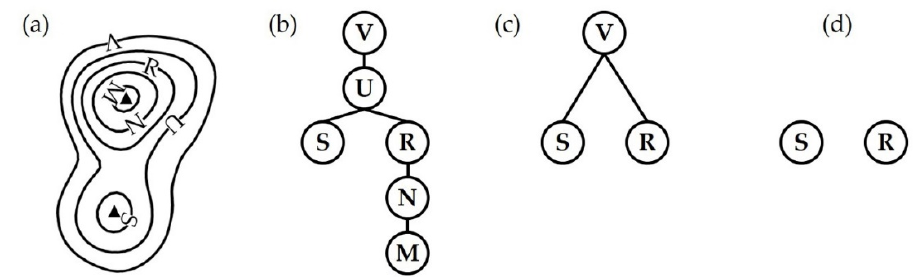
Figure 5. Localized contour tree generation diagrams. ( a ) Contour map. ( b ) Original contour tree. ( c ) Simplified contour tree. ( d ) Leaf nodes.